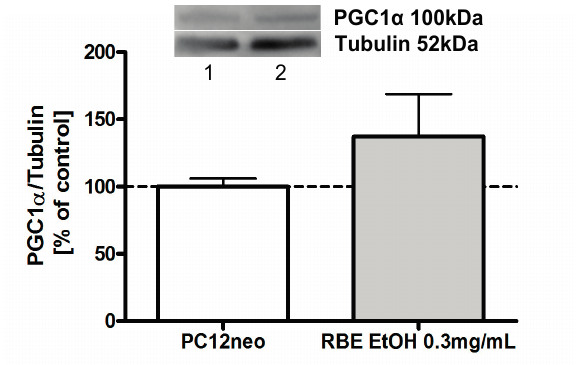
Figure 7. Protein expression of PGC1 α , a master regulator of mitochondrial biogenesis, was increased in PC12 cells after a 24-h incubation with ethanolic rice bran extract (RBE);